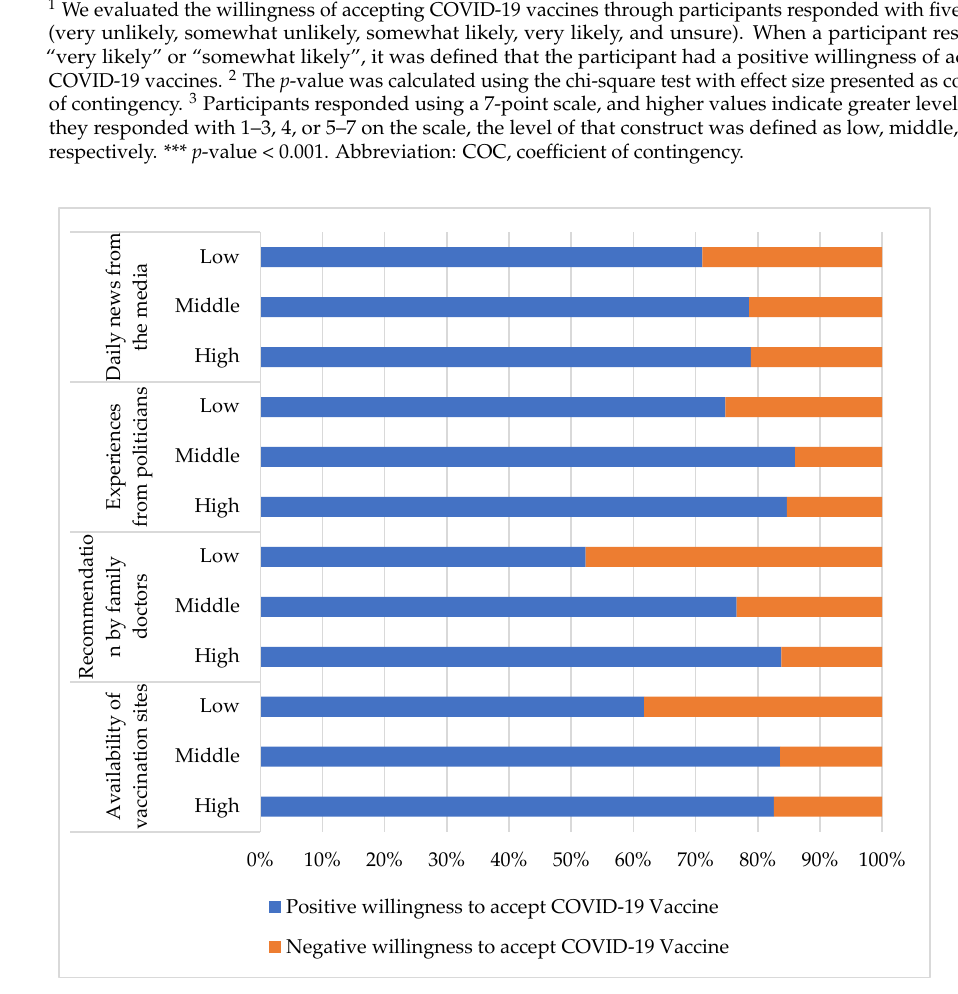
Figure 2. The percentages of positive and negative willingness to accept COVID-19 vaccine for each item in Table 3.